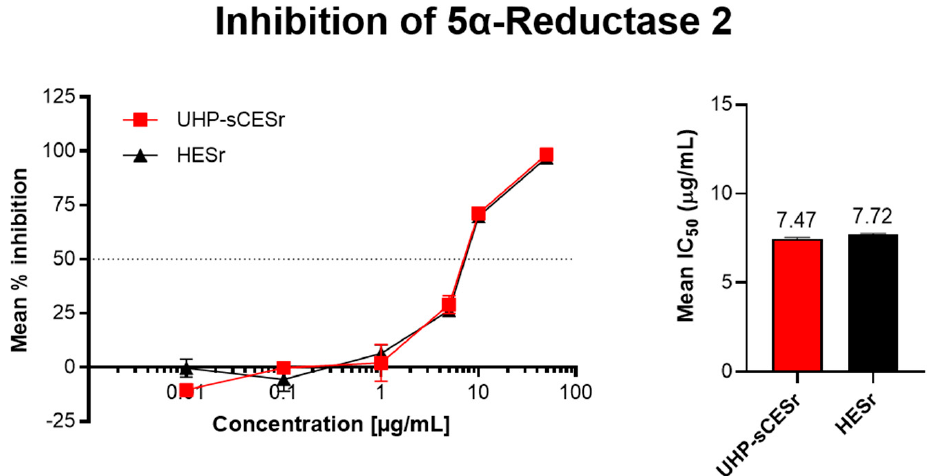
Figure 2. Inhibition of 5 α R-2 by an ultrahigh-pressure supercritical carbon dioxide extract of Serenoa repens (UHP-sCESr; lot 170710-PEG) and hexanic extract of S. repens (HESr; lot G06743). For the mean IC 50 values, error bars represent the standard error.